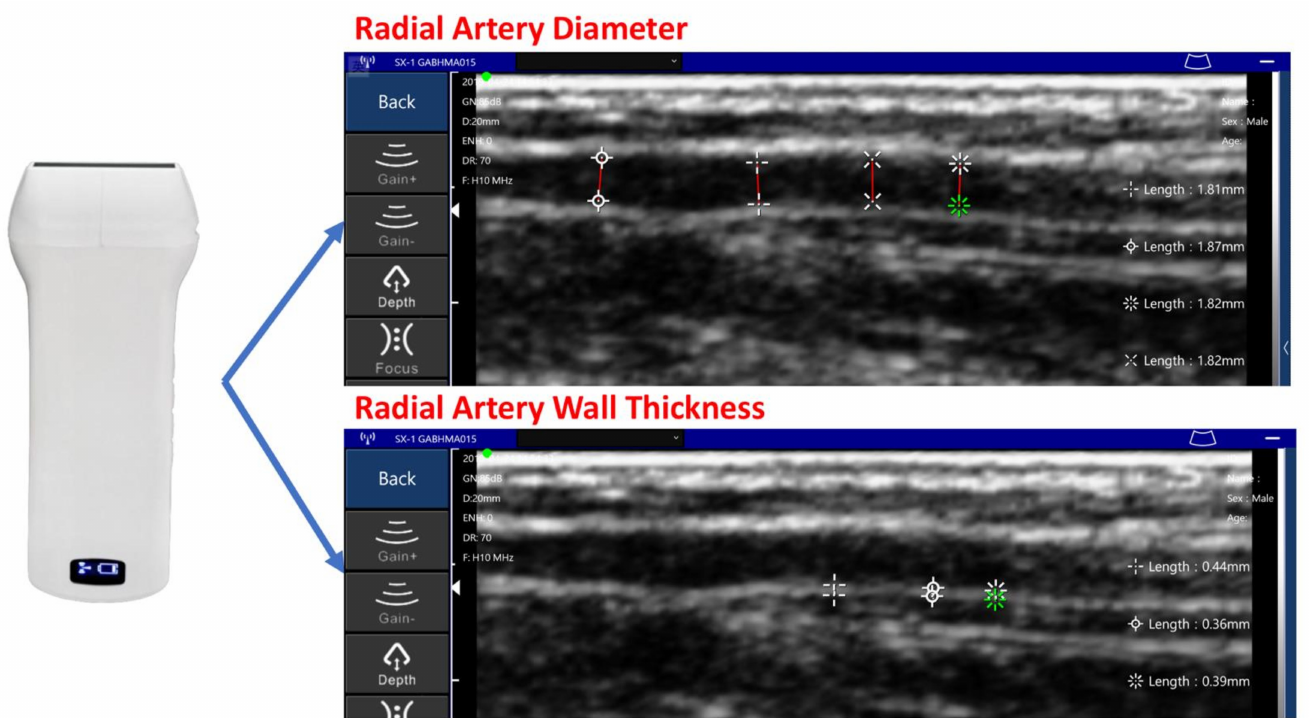
Figure 11. Ultrasound imaging device Sonostar U-Probe-L6C